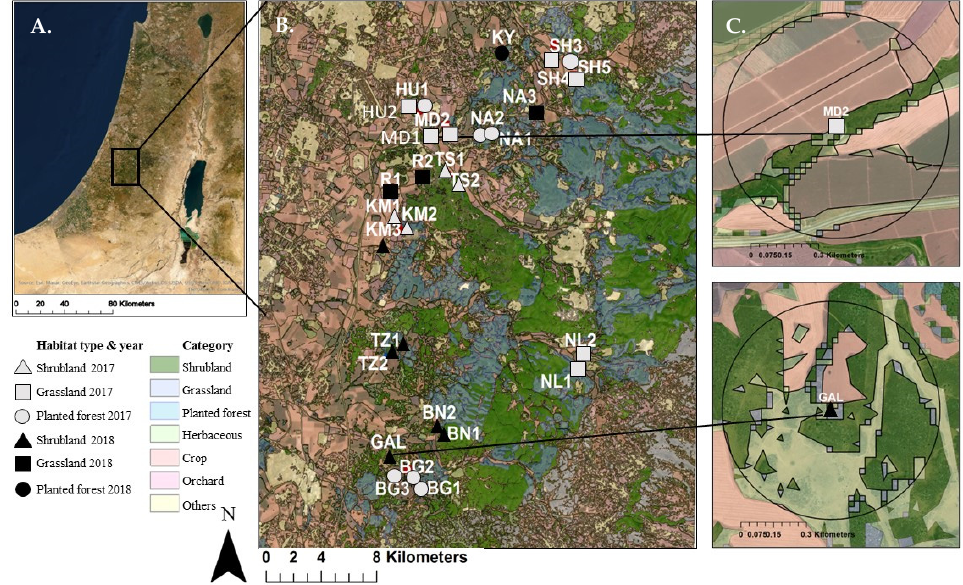
Figure 2. The study system: ( A ) Location in central Israel; ( B ) the studied landscape, land-use classification, and the spread of plots sampled each year; ( C ) two study plots at contrasting land-use context. See Table S1 for plot information.